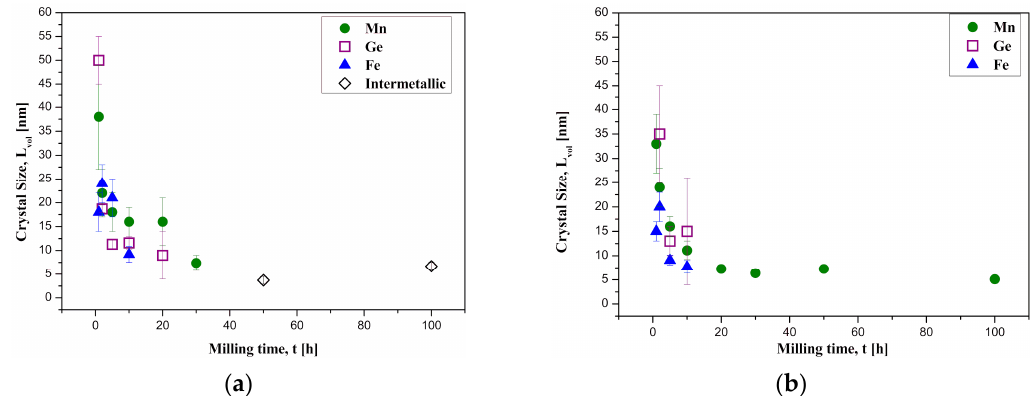
Figure 3. Crystal size from XRD Rietveld analysis as a function of the milling time: ( a ) Si-free alloy ( b ) Si-containing alloy.